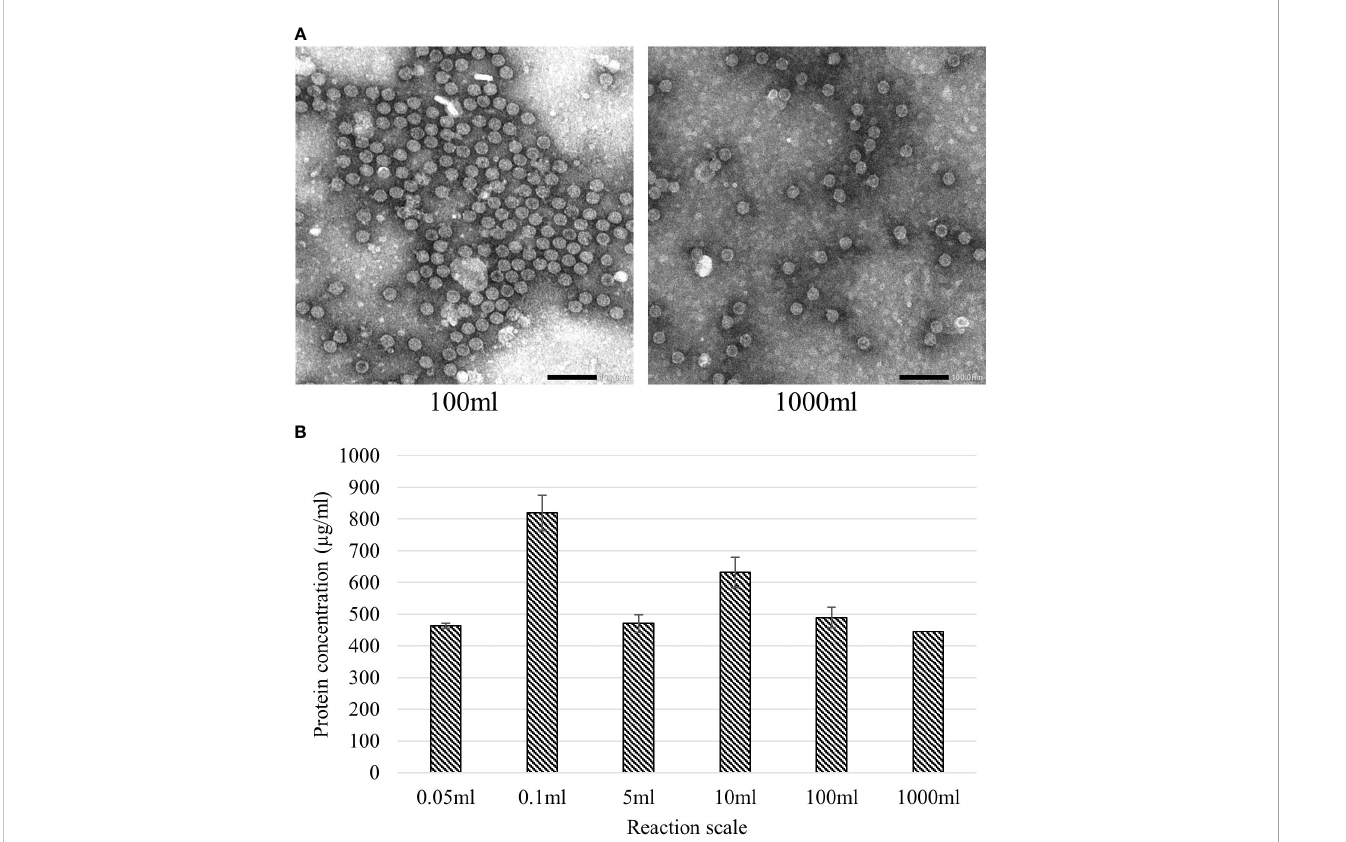
FIGURE 6 Effect of upscaling the BYL reaction volume on HBc VLP assembly and expression yield. (A) Transmission electron microscopy pictures of HBc VLPs produced at different scales in BYL (B) Calculated average of HBc VLP yields at the different BYL reaction scales. All expressions were performed in triplicate, except the 1000ml scale. HBc, hepatitis-B core antigen